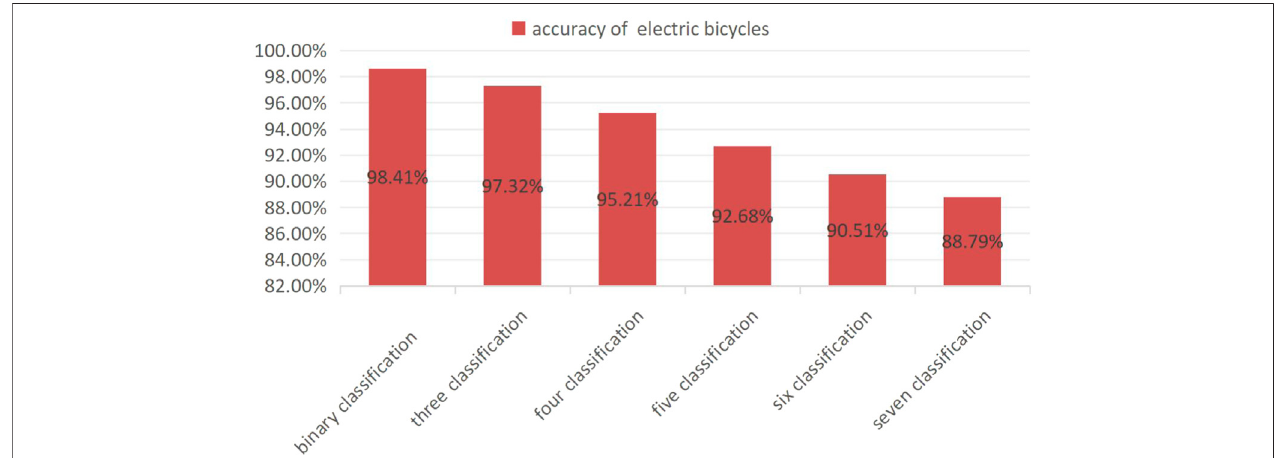
FIGURE 11 | Accuracy of electric bicycles under the two to seven classi fi cation DeiT model.